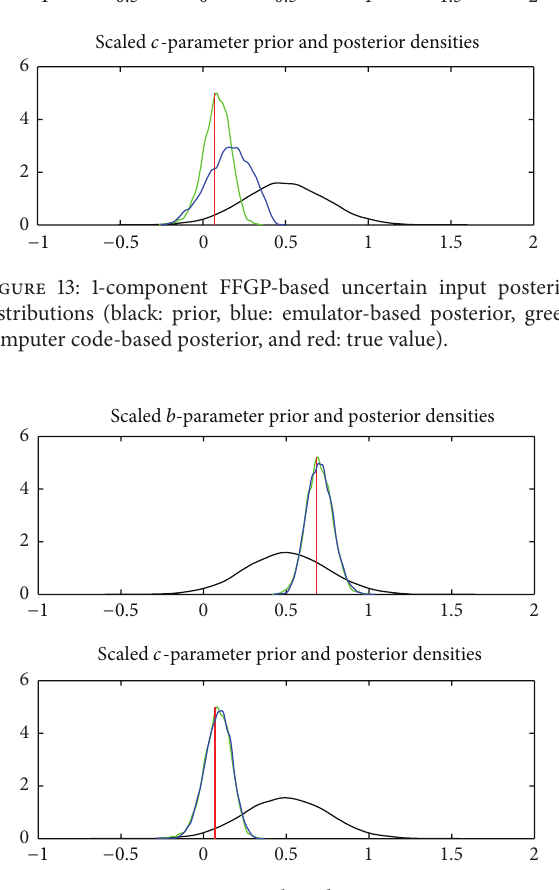
Figure 14: 2-component FFGP-based uncertain input posterior distributions (black: prior, blue: emulator-based posterior, green: computer code-based posterior, and red: true